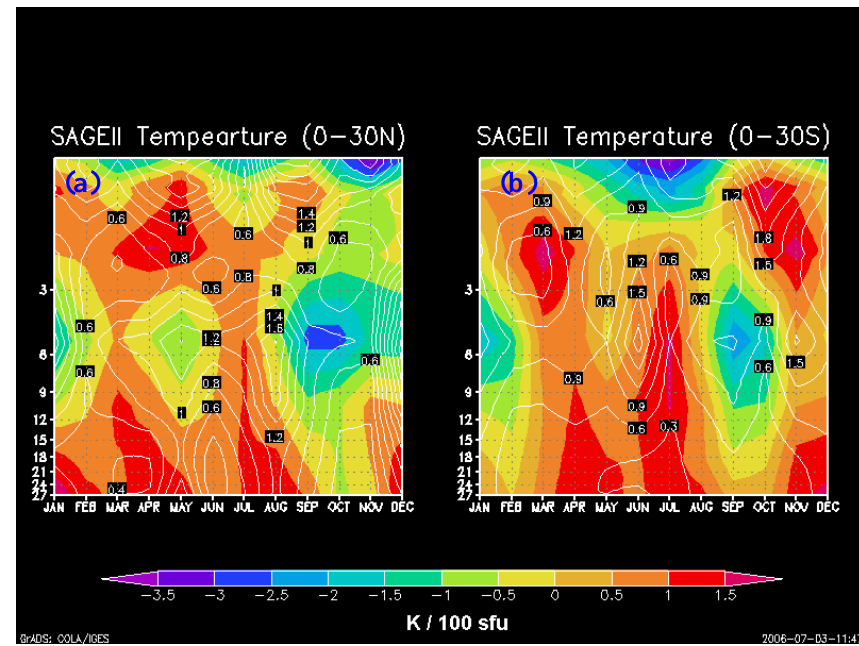
Fig. 7. Vertical distribution of monthly variation of solar coefficient (K/100sfu) obtained from SAGE II temperature (a) 0–30 ◦ N (b) 0–30 ◦ S. Monthly variation of 1sigma error (K/100sfu) in the solar effect on temperature is over-plotted with thin